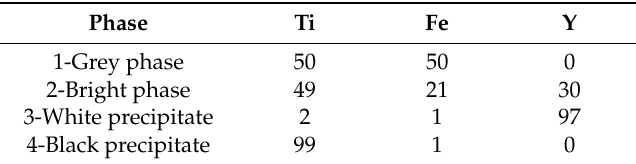
Table 4. Measured atomic abundance of the various phases presents in the TiFe alloy + 8 wt.% Y. All values are in at.%. The error on each value is ±1%.